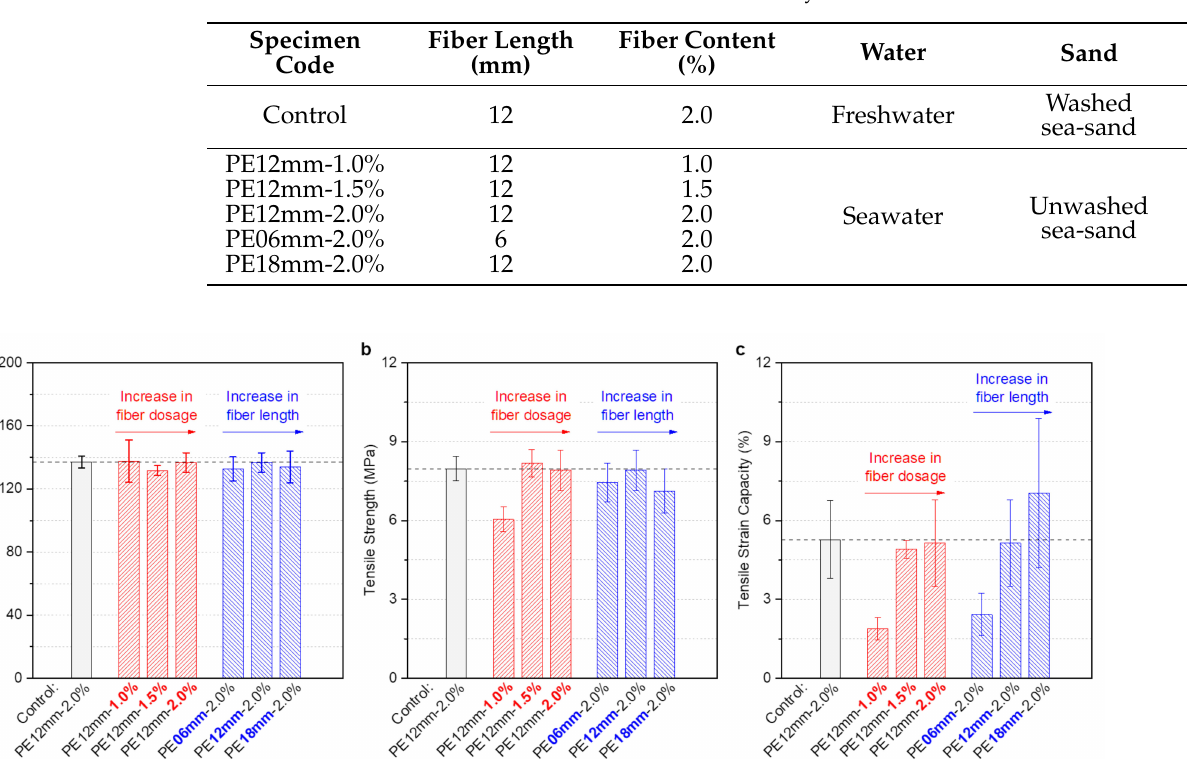
Table 3. Material IDs of SS-UHPC with PE fibers in this study.